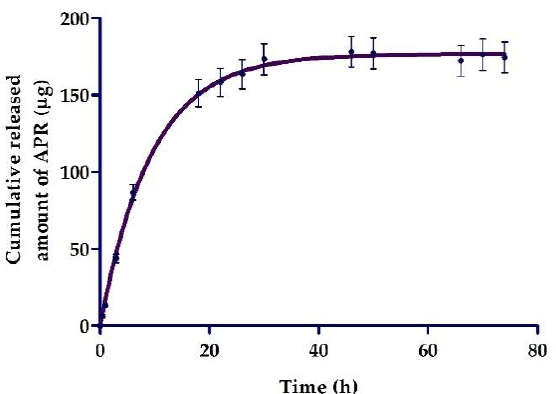
Figure 5. In vitro release profile of apremilast (APR) from microemulsion.